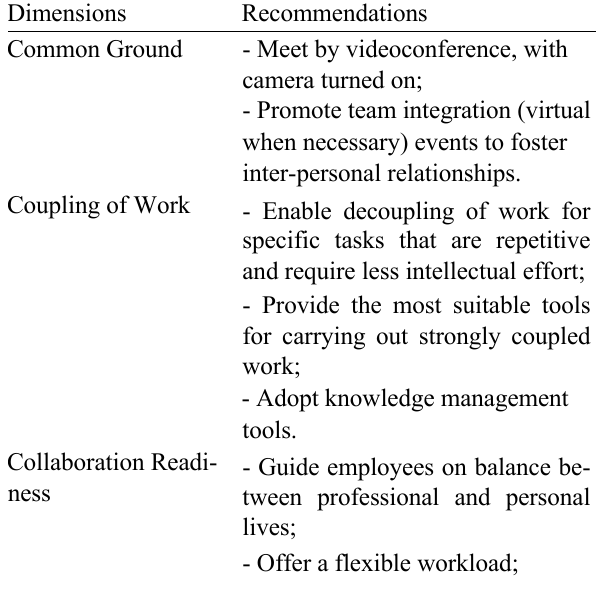
Table 1. Summary of